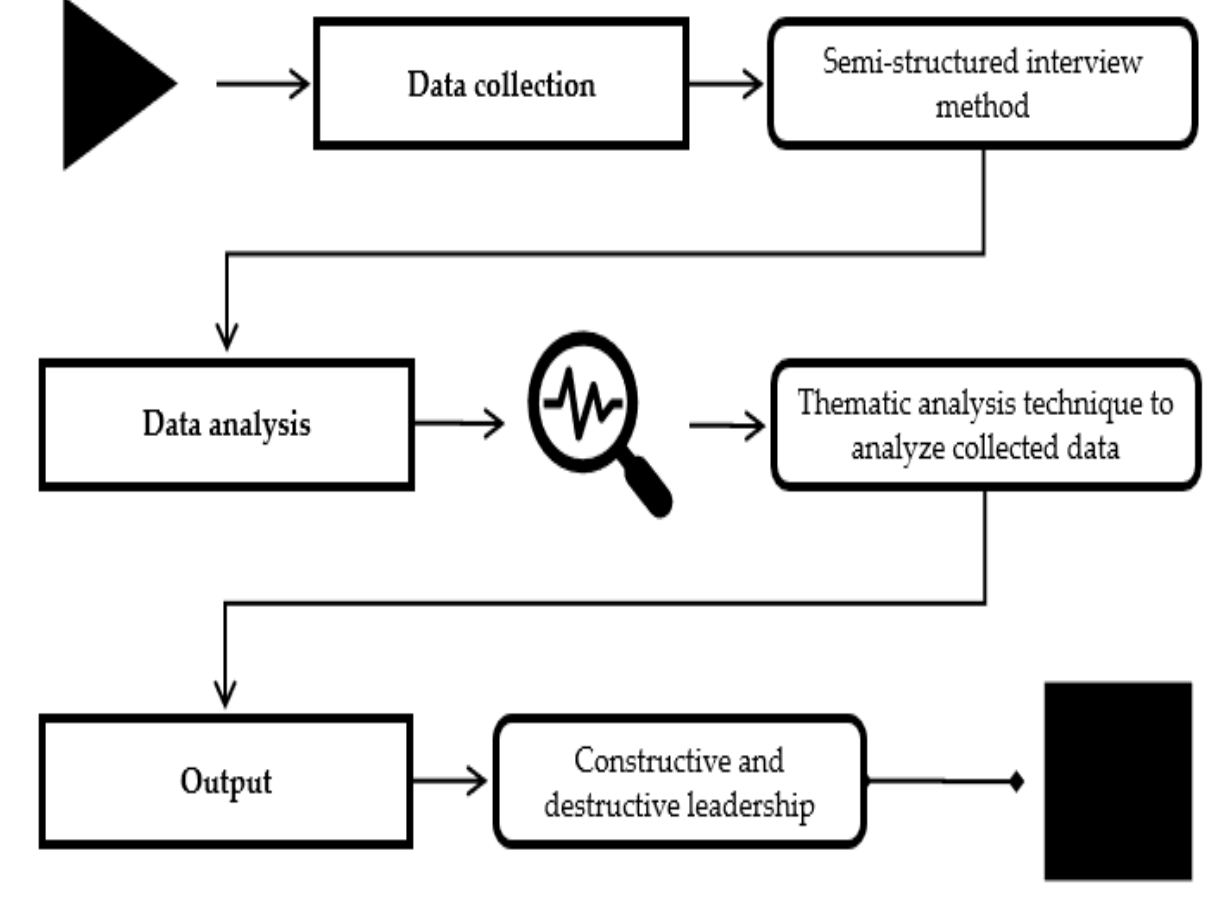
Figure 1. Overview of the methodology for this study.